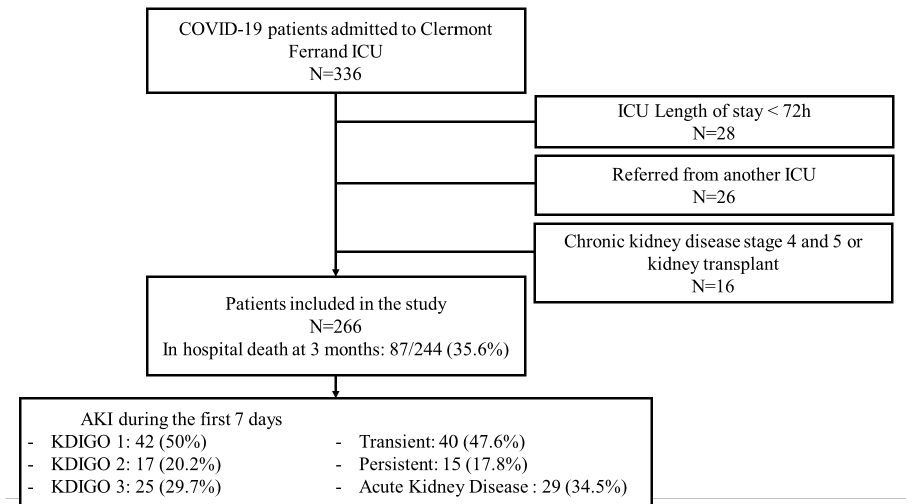
Figure 1. COVID-19 patient flow diagram. ICU: intensive care unit; AKI: acute kidney injury; KDIGO: Kidney Disease Improving Global Outcomes. Table 1 . Characteristics of critically ill COVID-19 patients according to the occurrence of early-onset acute kidney injury. VARIABLES, n (%) or Median